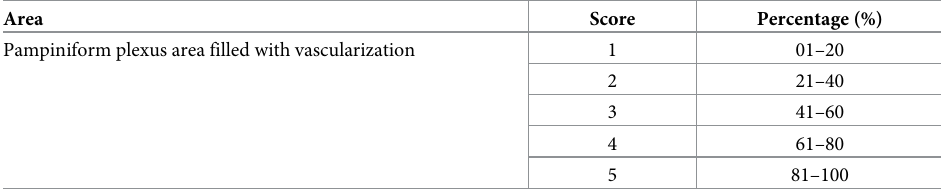
Table 1. Score used to evaluate pampiniform plexus of boars housed in three different conditions.